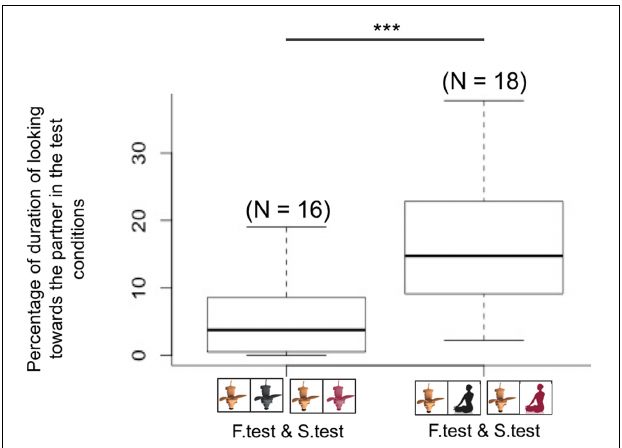
FIGURE 5 | Dogs paired with conspecific partners spent less time looking at their partner than dogs paired with humans in both test conditions (familiar and stranger test conditions, ∗∗∗ p <